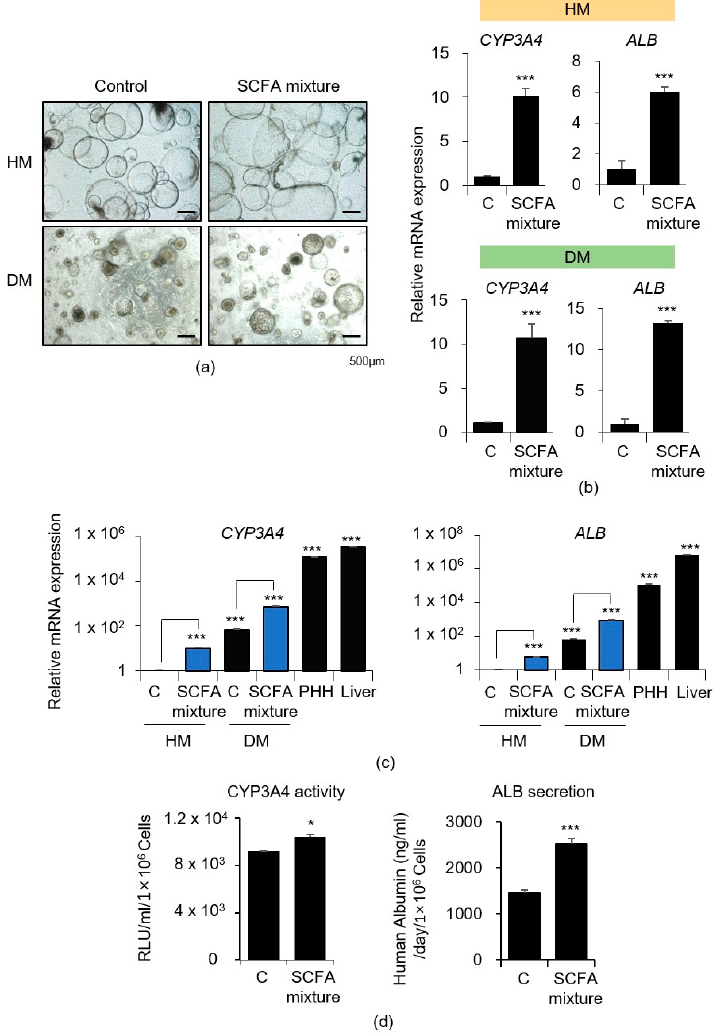
Figure 3. Effects of SCFA mixture on iPSCs-derived liver organoids. ( a ) Representative morphology of the untreated control and SCFA mixture-treated HM (upper)- and DM (lower)-cultured organoids are shown. ( b ) CYP3A4 and ALB mRNA expression levels in the control and SCFA mixture-treated HM (upper)- and DM (lower)-cultured organoids are shown. ( c ) CYP3A4 (left) and ALB (right) mRNA expression levels in the untreated control, SCFA mixture-treated group, primary human hepatocytes (PHHs), and adult liver tissue are shown. ( d ) CYP3A4 activity (left) and ALB secretion (right) in control and SCFA mixture-treated DM organoids are shown. Data are presented as the mean ± SEM ( n = 3) and analyzed by Student’s t -test. * p < 0.05 and *** p <